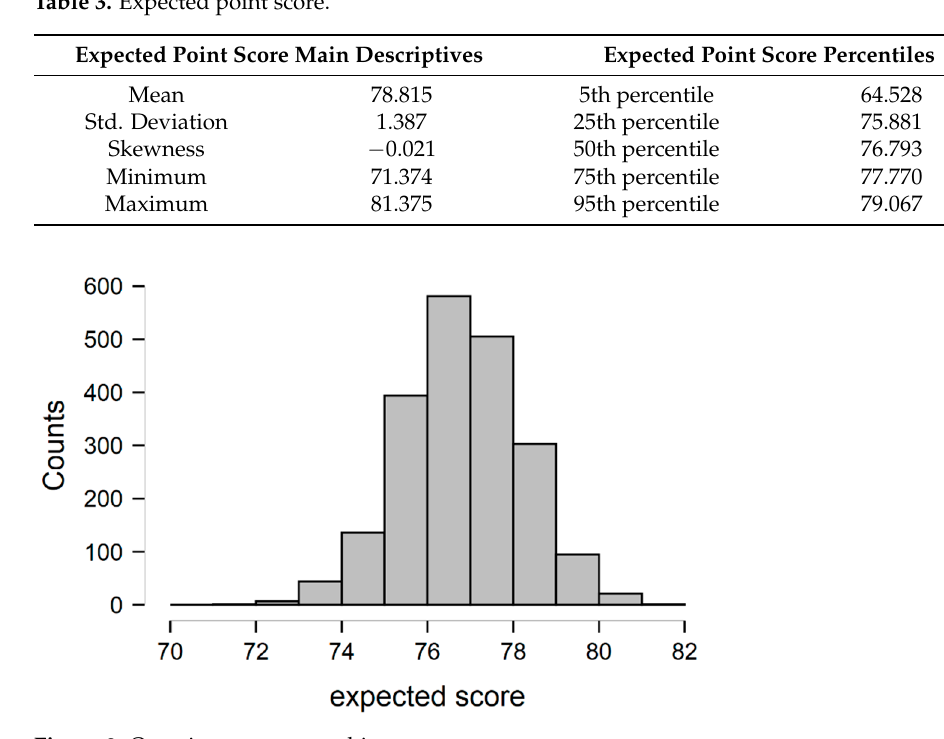
Figure 2. Question success rate histogram.